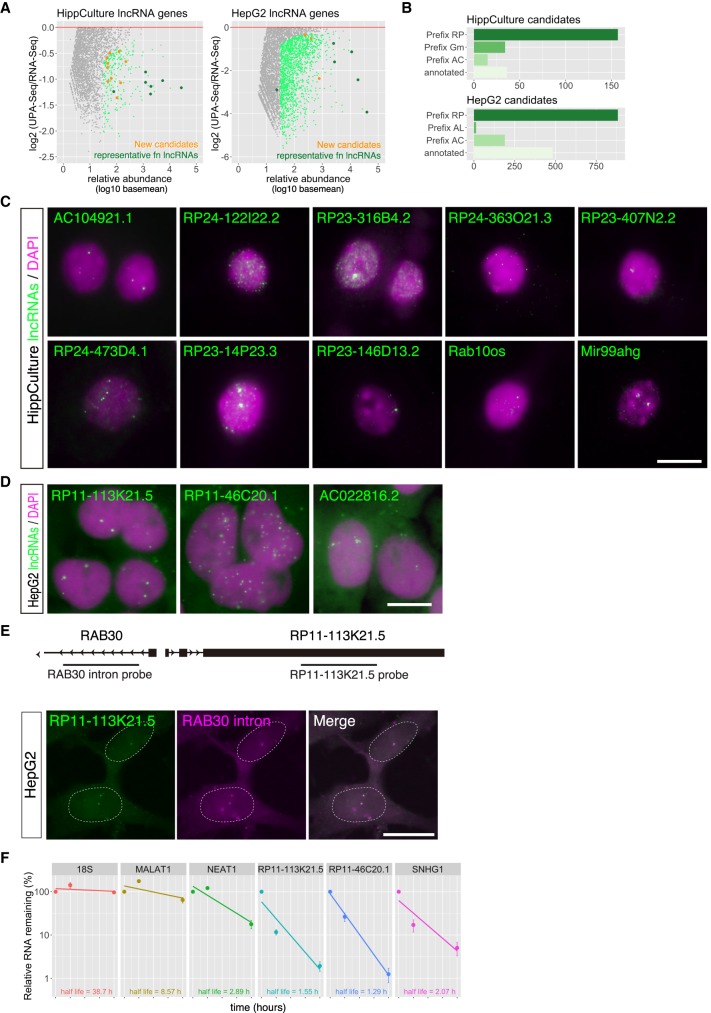

Identification of novel functional lncRNA candidates by UPA-seq. (A) MA-plot of log2 fold change of reads upon UV irradiation in HippCulture and HepG2 cells as a function of the relative abundance (log10 baseMeans). Light green dots represent lncRNAs that exhibited significant (FDR < 0.05) fold change, orange dots represent functional lncRNA candidates used for the following FISH studies, and dark green dots represent known functional lncRNAs. Note that only lncRNAs with negative log2 fold change values are illustrated. (B) Group of functional lncRNA candidates that exhibited significant decrease (FDR < 0.05) upon UV irradiation. Genes are categorized into known genes (annotated) and unknown genes assigned with ID numbers with various prefixes (RP, Gm, AC, and AL). (C,D) FISH images showing the subcellular distribution of functional lncRNA candidates (green) in HippCulture cells (C) and HepG2 cells (D). Magenta denotes nuclei counterstained with DAPI. Scale bar, 10 µm. (E) Schematic illustration showing the gene organization at the Rab30/RP11-113K21.5 locus and the positions of the probes used for simultaneous detection. Note that the signals obtained with probes that detect RP11-113K21.5 were closely associated with the signals obtained with probes that detect Rab30 intron sequences. Dashed lines represent the position of the nucleus. Scale bar, 10 µm. (F) Half-lives of 18S rRNA, MALAT1, NEAT1, RP11-113K21.5, RP11-46C20.1, and SNHG1, as measured by BRIC RT-qPCR. Note that the functional lncRNA candidates exhibited relatively short half-lives.